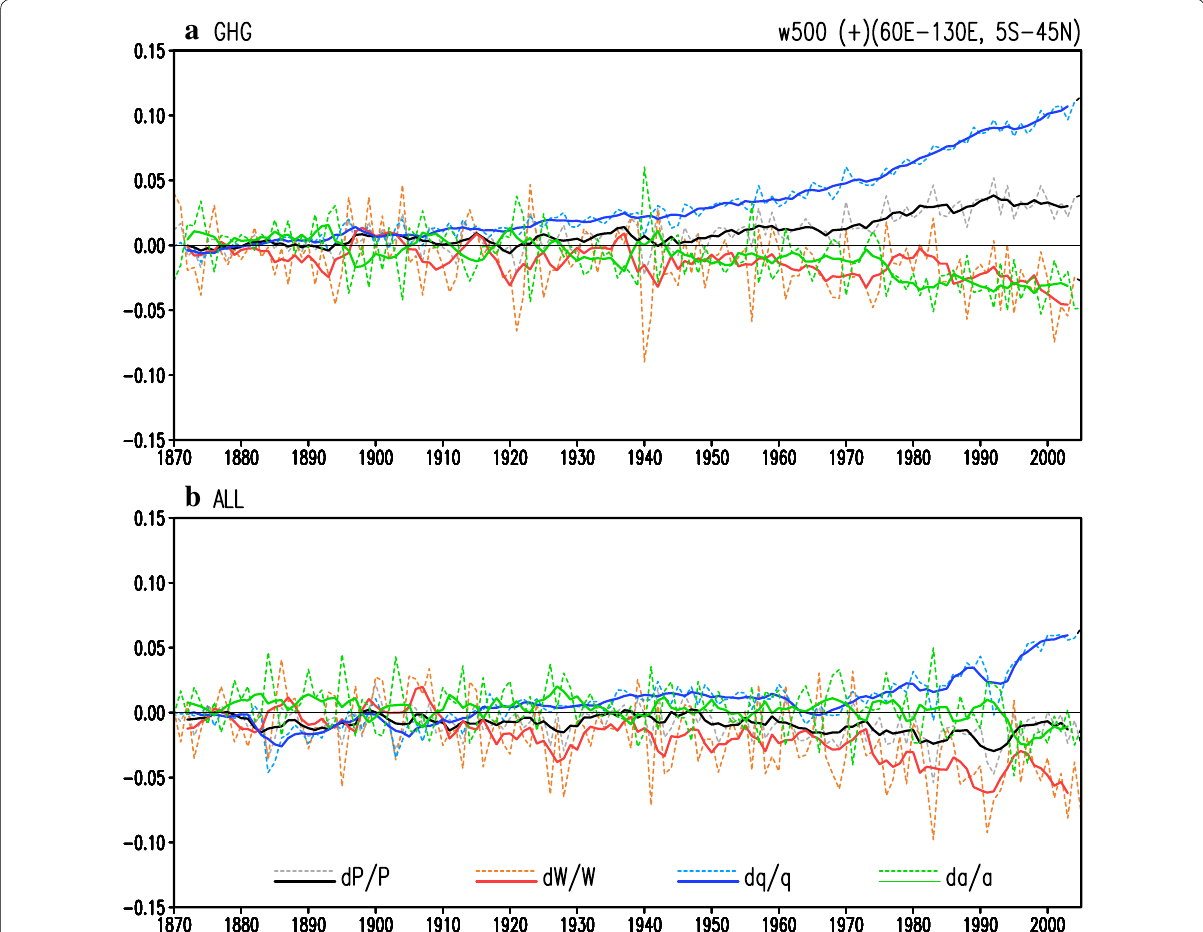
Fig. 4 Time series (1870–2005) showing fractional change of precipitation (d P / P ), 500 hPa vertical motion (d w / w ), moisture (d q / q ), and precipita‑ tion efficiency (d α / α ) over the ASM domain for ( a ) GHG and ( b ) ALL. Dotted and solid lines indicate JJA mean and 5‑year mean